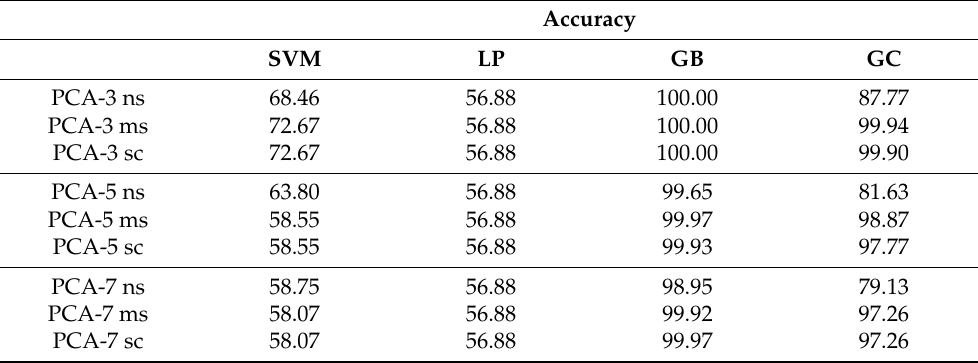
Table 1. The classification accuracy for HSI2 image 1 using PCA 3, 5, and 7 bands and the different scaling and normalization methods using the four machines for a 1500 pixels batch size.